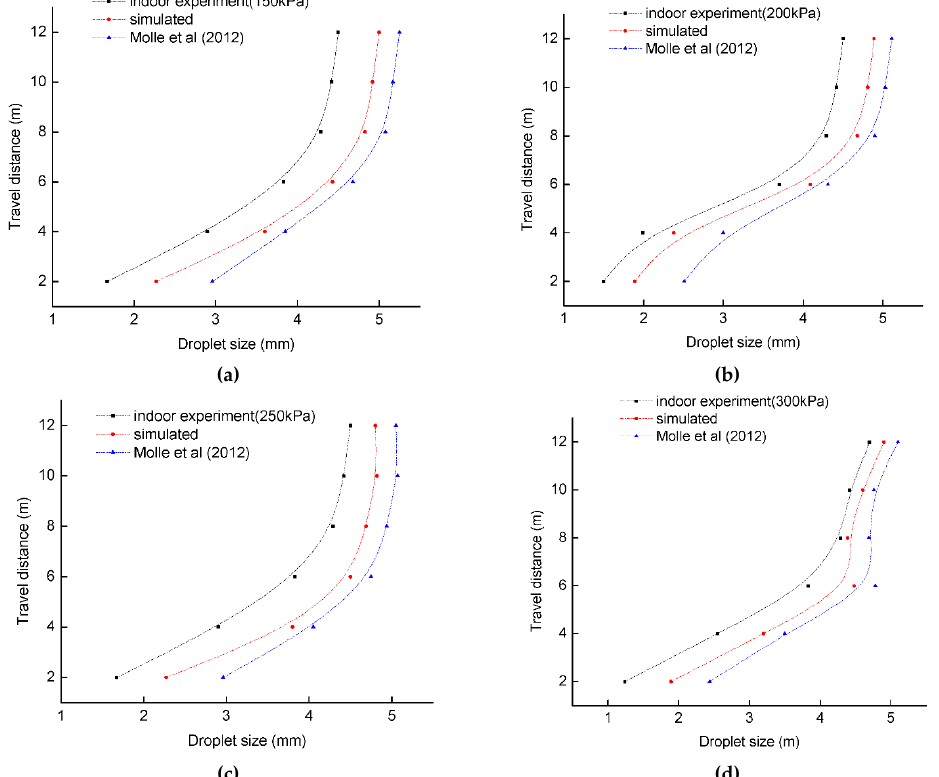
Figure 5. Comparison between experiment, simulated and Molle et al. (2012) [7]. ( a ) 150 kPa, ( b ) 200 kPa, ( c ) 250 kPa, and ( d ) 300 kPa. 3.4. Compare the Droplet Size Distribution Model Prediction in Zero and Windy Conditions The computer model was used to simulate droplet travel distances from the sprinkler for three wind speeds with downwind direction, and zero wind conditions are compared